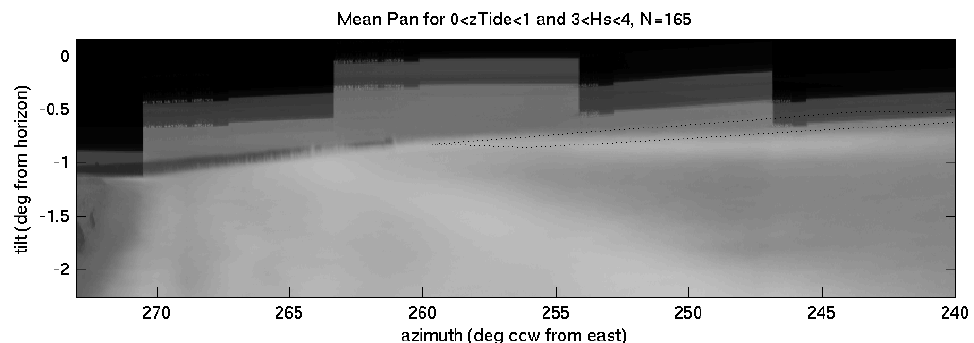
Figure 5. Example of averaged pan “brightest” image for North Head for the 165 images for which the tide elevation was between 0 and 1 m and the wave height was between 3 and 4 m. The SWS disposal site is shown by the black dotted lines extending from the end of the jetty.